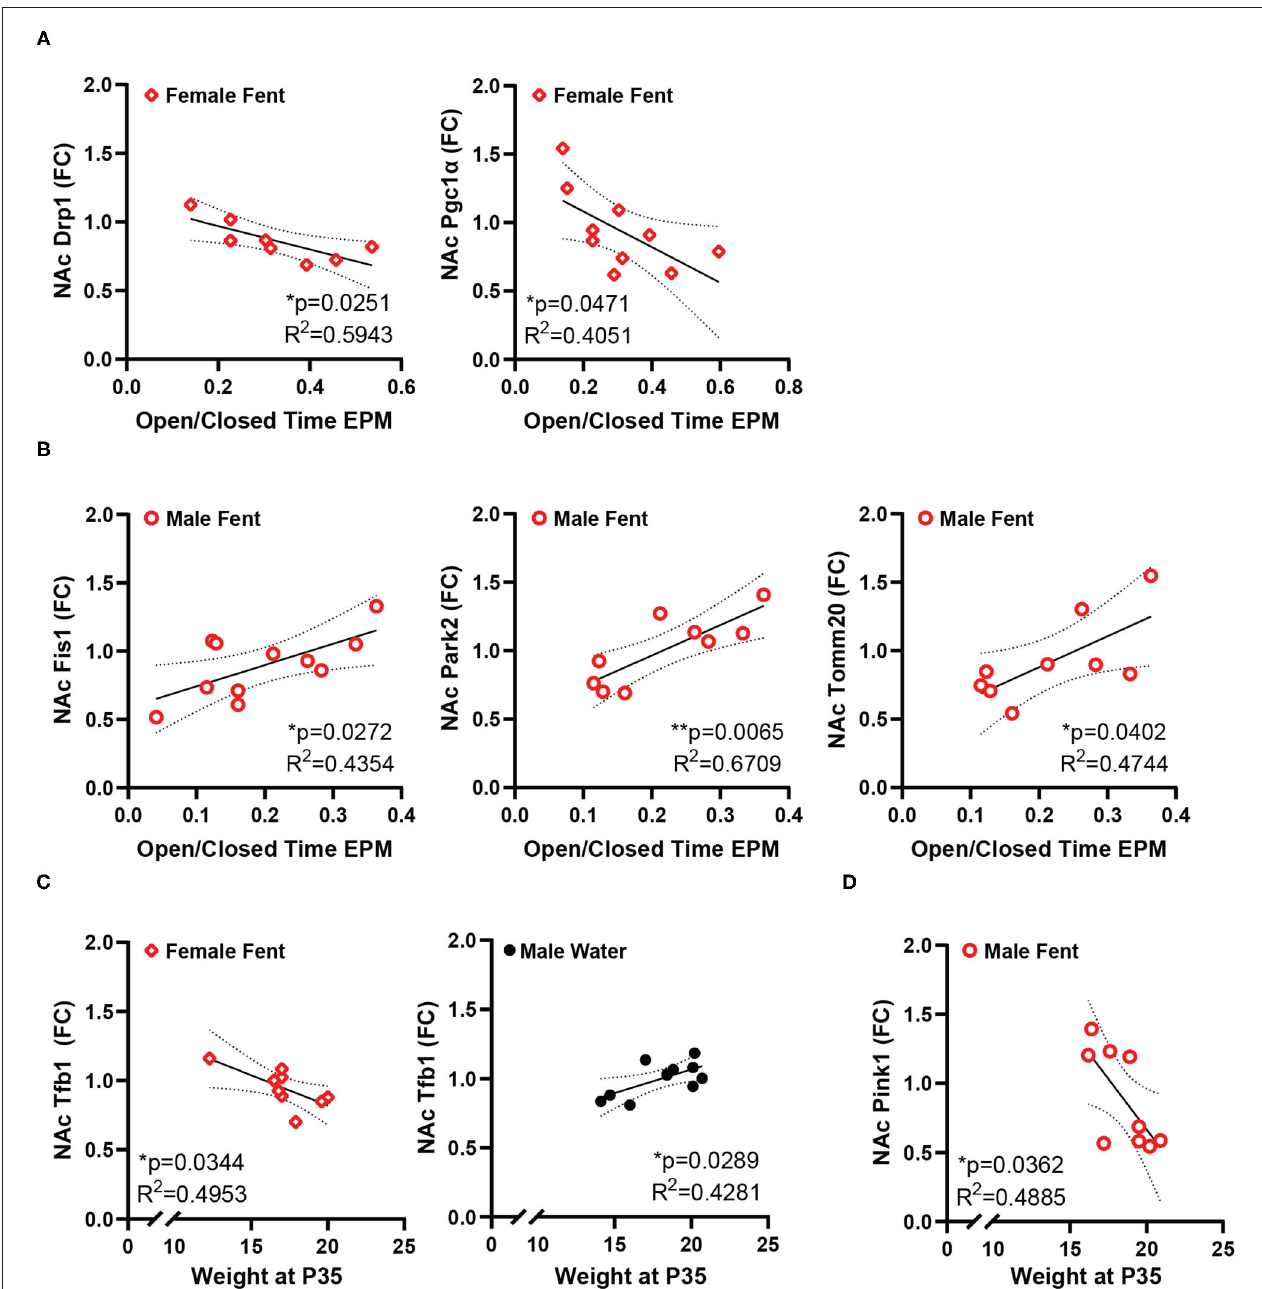
FIGURE 3 | NAc mitochondrial gene expression correlates with anxiety-like behavior and weight. (A) In female mice developmentally exposed to fentanyl, NAc expression of Drp1 and Pgc1 α correlate with behavior in the EPM, represented as the ratio of open/closed arm time. (B) In male mice developmentally exposed to fentanyl, NAc expression of Fis1, Park2, and Tomm20 correlate with behavior in the EPM, represented as the ratio of open/closed arm time. (C) NAc expression of Tfb1 positively correlates with weight at P35 in female mice developmentally exposed to fentanyl and negatively correlates with weight in male control mice. (D) In male mice developmentally exposed to fentanyl, NAc expression of Pink1 negatively correlates with weight at P35. Gene expression is depicted as fold change. * p < 0.05; ** p < 0.01.